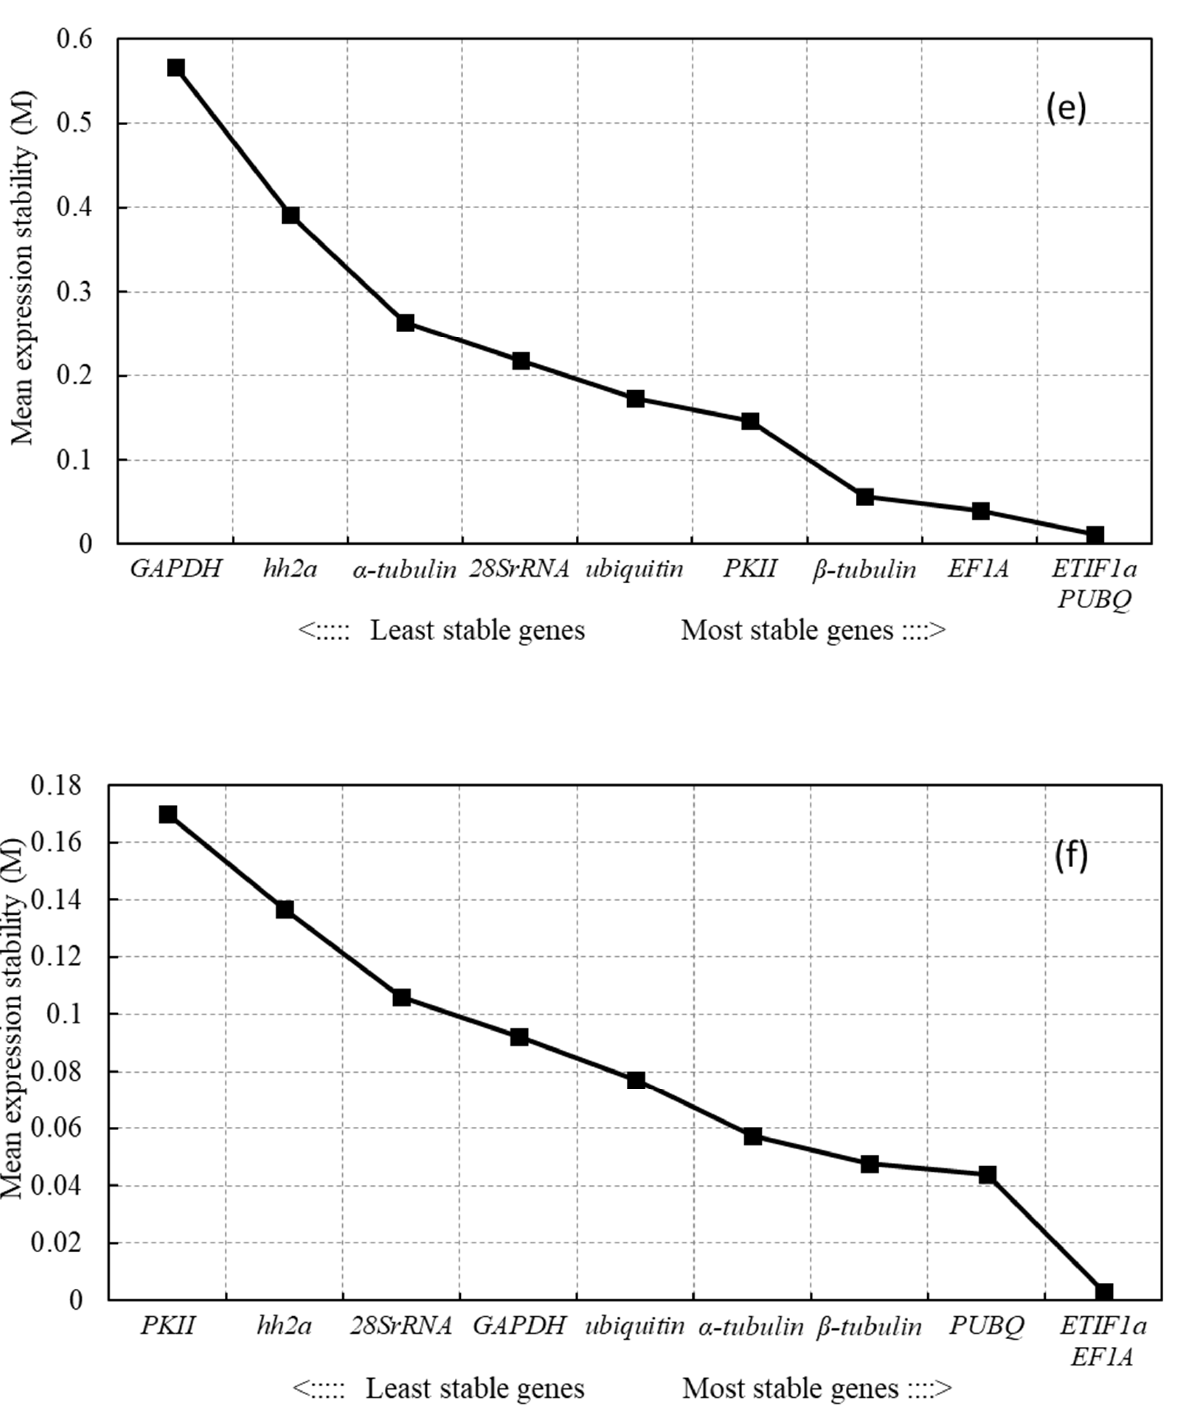
Figure 3. Expression stability and ranking of 10 candidate reference genes calculated by geNorm. The mean expression stability was calculated by a stepwise exclusion of the least stable gene across all samples. The least stable genes are on the leftand the most stable ones on the right. The statistical analysis of the expression stability was performed for all of the tested samples (Total) and separately for each growth stage for the rhizome samples and for the samples of the leaves of the cultivated and wild plants. ( a ) Total: all rhizome and leaf samples of cultivated and wild plants; ( b ) VR: rhizomes at the vegetative stage; ( c ) VL: leaves at the vegetative stage; ( d ) FR: rhizomes at the flowering stage; ( e ) FL: leaves at the flowering stage; ( f ) WR: rhizomes at the withering stage.